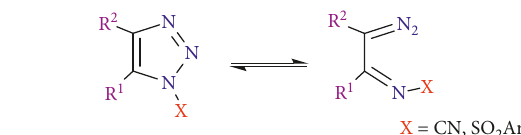
Scheme 3: Effect of the electron withdrawing groups on the N-1 atom in the 1,2,3-triazoles on the rin stability.